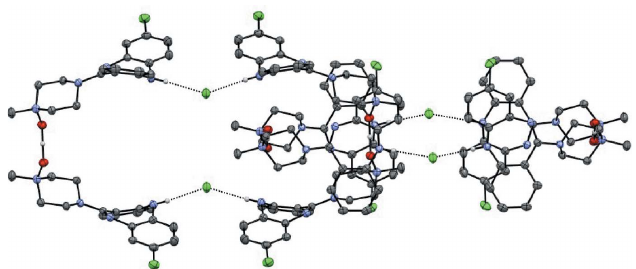
Figure 3 Partial structure of (CNO) 2 (cid:2) HCl catenated chain showing two members of the poly[ n ]catenane; adjacent links in the chain are related by a 4 2 screw axis.